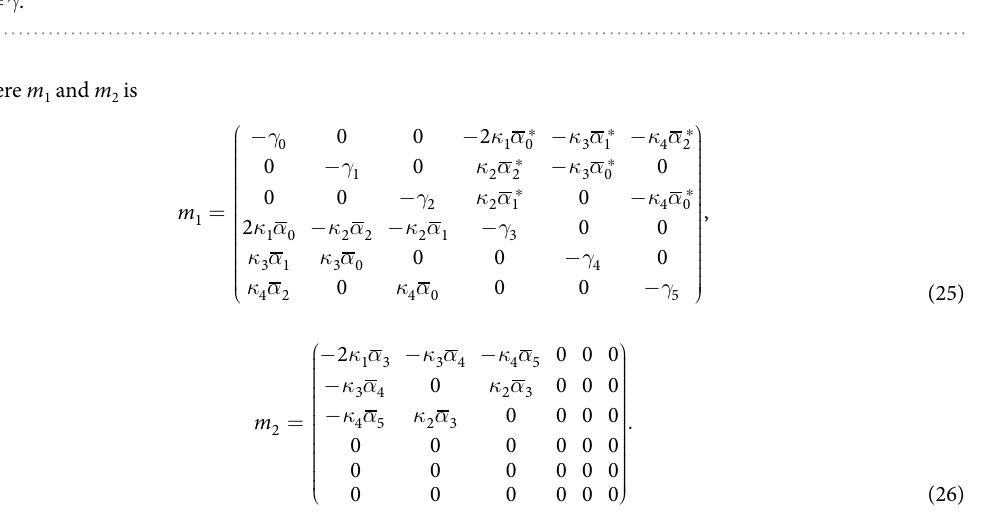
Figure 6. Extracavity variance versus frequency of pump power. The external coupling coefficient is fixed at: = γ γ c